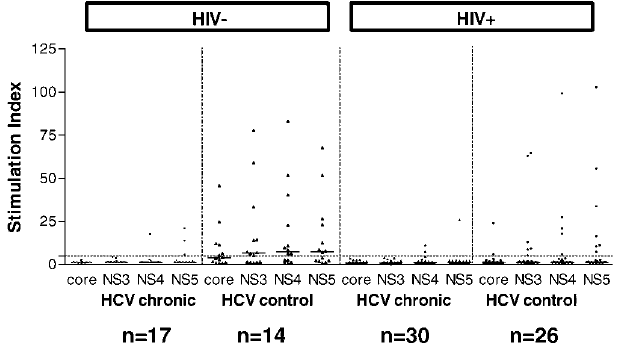
Figure 2. LP Responses to HCV Antigens Are Associated with Spontaneous Control of Viremia Regardless of HIV Status Stimulation indices to HCV proteins are plotted per subgroup. The two plots on the left represent responses in HIV (cid:1) persons; the two on the right in HIV þ . Cutoff of significance for lymphoproliferation was an SI of 5, shown by horizontal dotted line. Median values are also